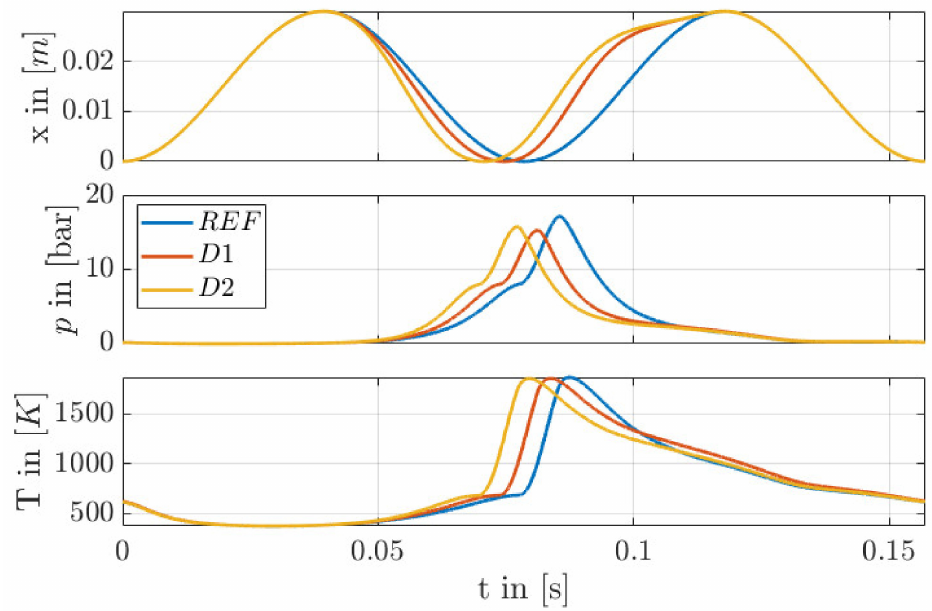
Figure 30. Comparison of trajectories REF, D1 and D2 related to the energy conversion of the internal combustion engine: illustration of the stroke, cylinder pressure and temperature depending on